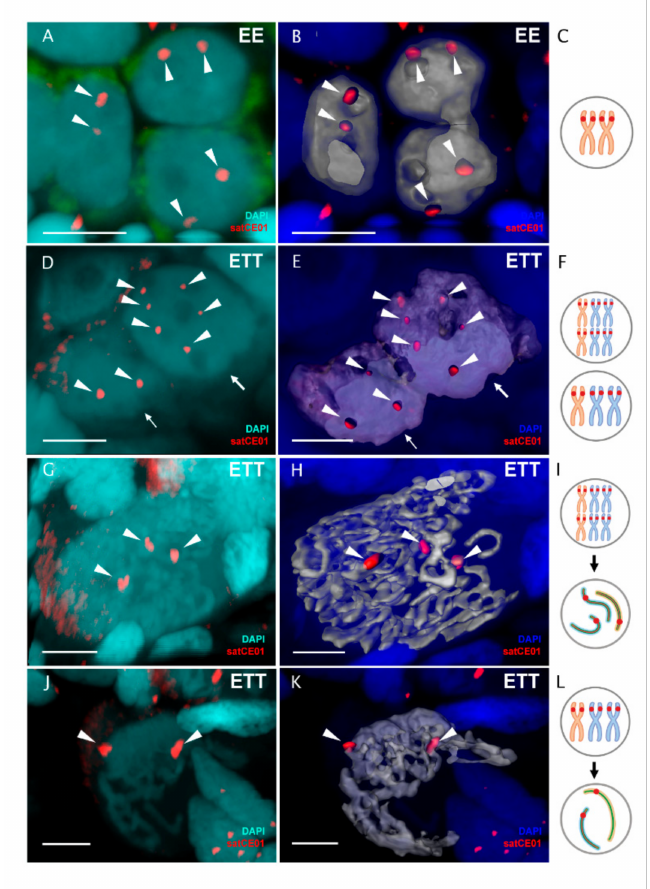
Figure 5. Identification of germ cell ploidy level using FISH with chromosome-specific probe in C. elongatoides , and triploid hybrids. Whole-mount FISH with chromosome-specific marker